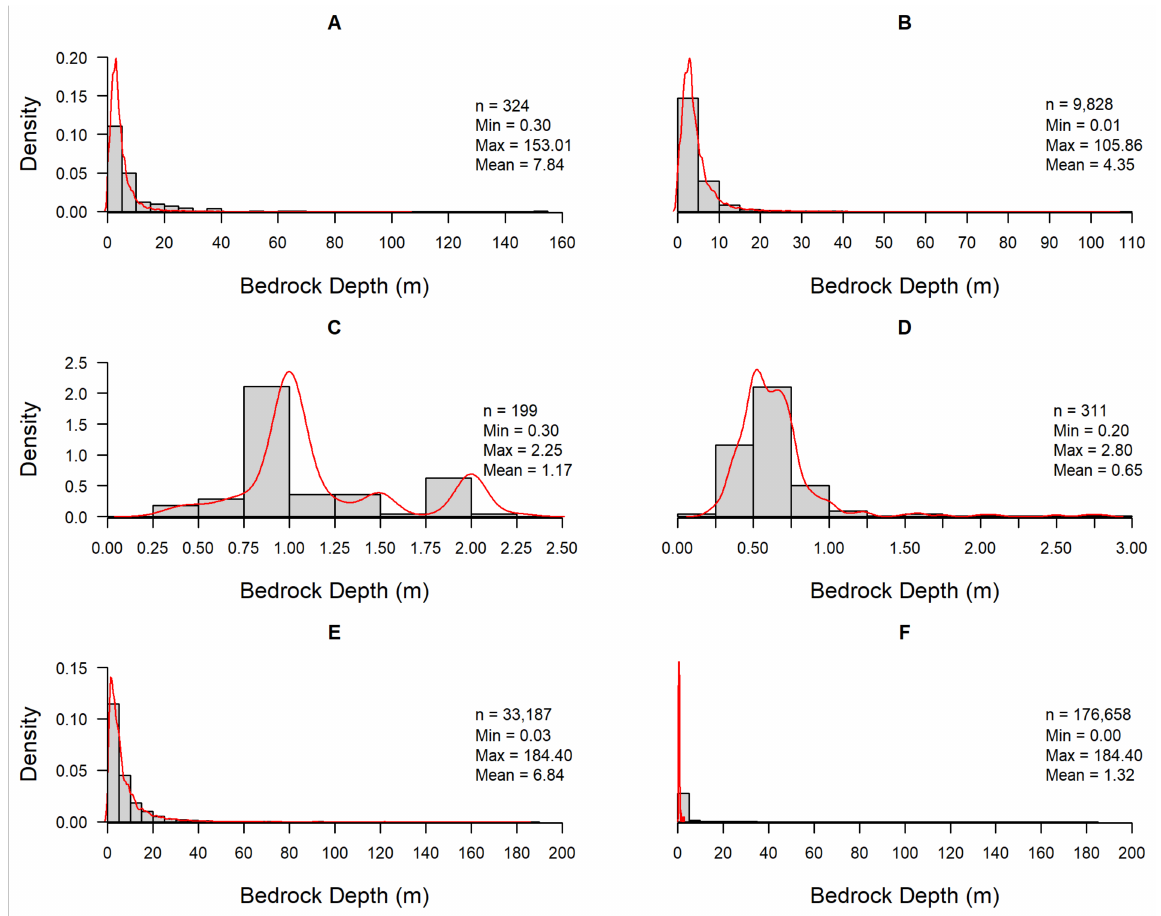
Figure 3. Histogram and continuous density distribution (red line) of bedrock depth for boreholes ( A ), drillholes ( B ), pedons ( C ), site cards ( D ), and well logs ( E ), and all data combined ( F ), including sample size, minimum, maximum, and mean DTB values for each source. Note: Depth intervals are (i) 0.25 m for pedons and site cards, and 5 m for the remaining sources, and (ii) the total sample size with minimum, maximum, and mean exclude the rock outcrop samples since all of these samples have a DTB of